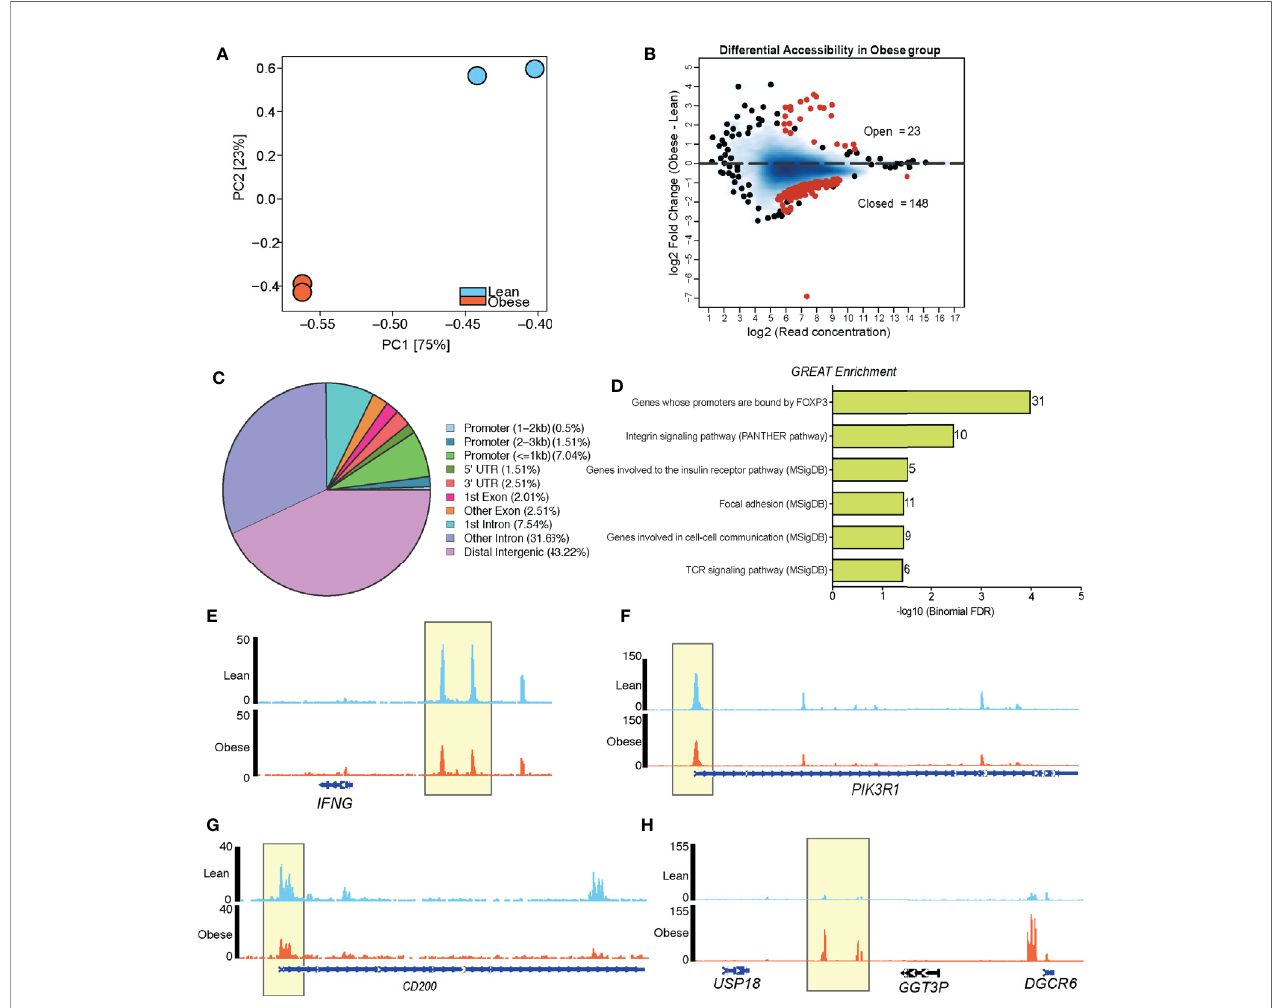
FIGURE 4 | Maternal BMI is associated with distinct chromatin accessibility pro fi les of loci regulating T cell signaling in cord blood CD4+ cells. (A) PCA of chromatin accessibility pro fi les of resting CD4+ T cells (n=2/group). (B) MA plots showing fold changes and coverage of accessible loci. Differentially accessible regions (obese vs leans) are highlighted in red. (C) Pie chart showing genomic contexts of DARs in resting cord blood CD4 T cells from obese group relative to lean group. (D) Cis-regulatory associations of DARs closed in CD4+ T cells of obese group identi fi ed using GREAT. (E – H) Pileups of select genes with reduced accessibility (E – G) and enhanced accessibility (H) in cord blood CD4 T cells from babies born to mothers with